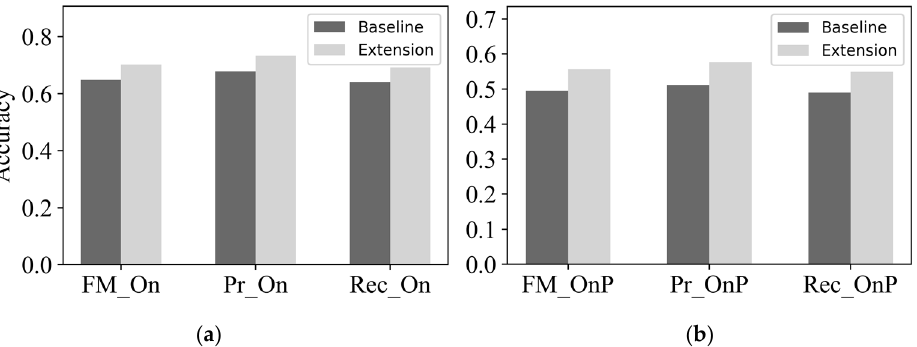
Figure 12. Overall result after 150 ms onset difference: ( a ) represents on results, ( b ) represents OnP results.